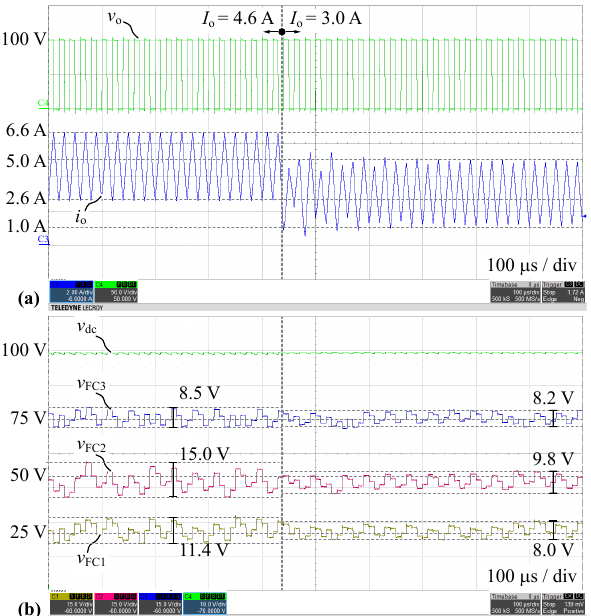
Figure 17. Measured waveforms for Q2L-5L-FCC in configuration 2 (cid:13) with CL balancing during a negative load step from 100% to 67% of the nominal load ( I o = 4.6A → 3.0A, ∆ I pp = 4A): ( a ) Output voltage v o and current i o , ( b ) DC-link capacitor voltage v dc and FC voltages v FC{1,2,3} . Delay times T delay = { 50,100 } ns are